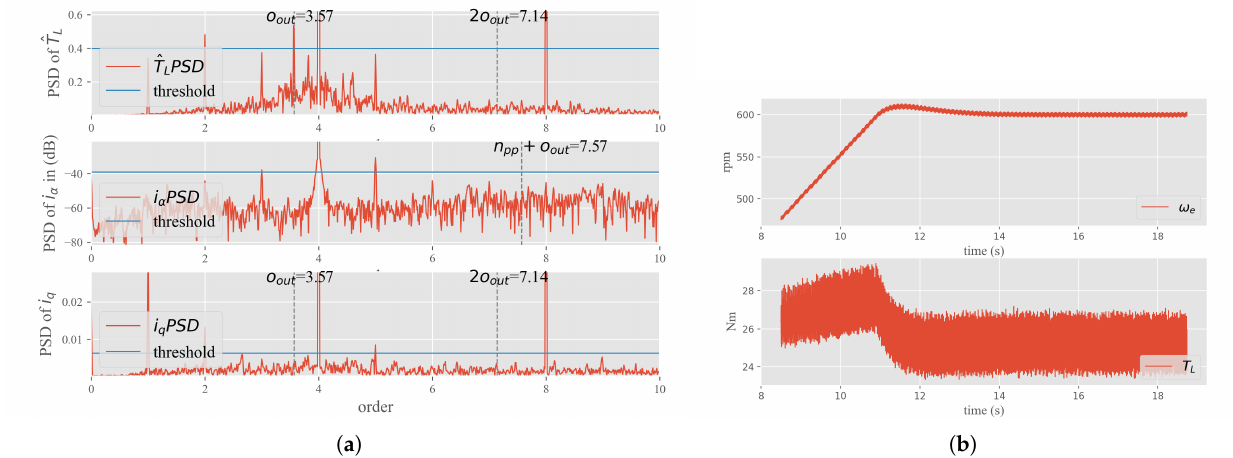
Figure 8. Speed varying experiments (Case1) of the bearing fault motor ( a ) power spectrum density and ( b ) graphical transients of speed and torque.